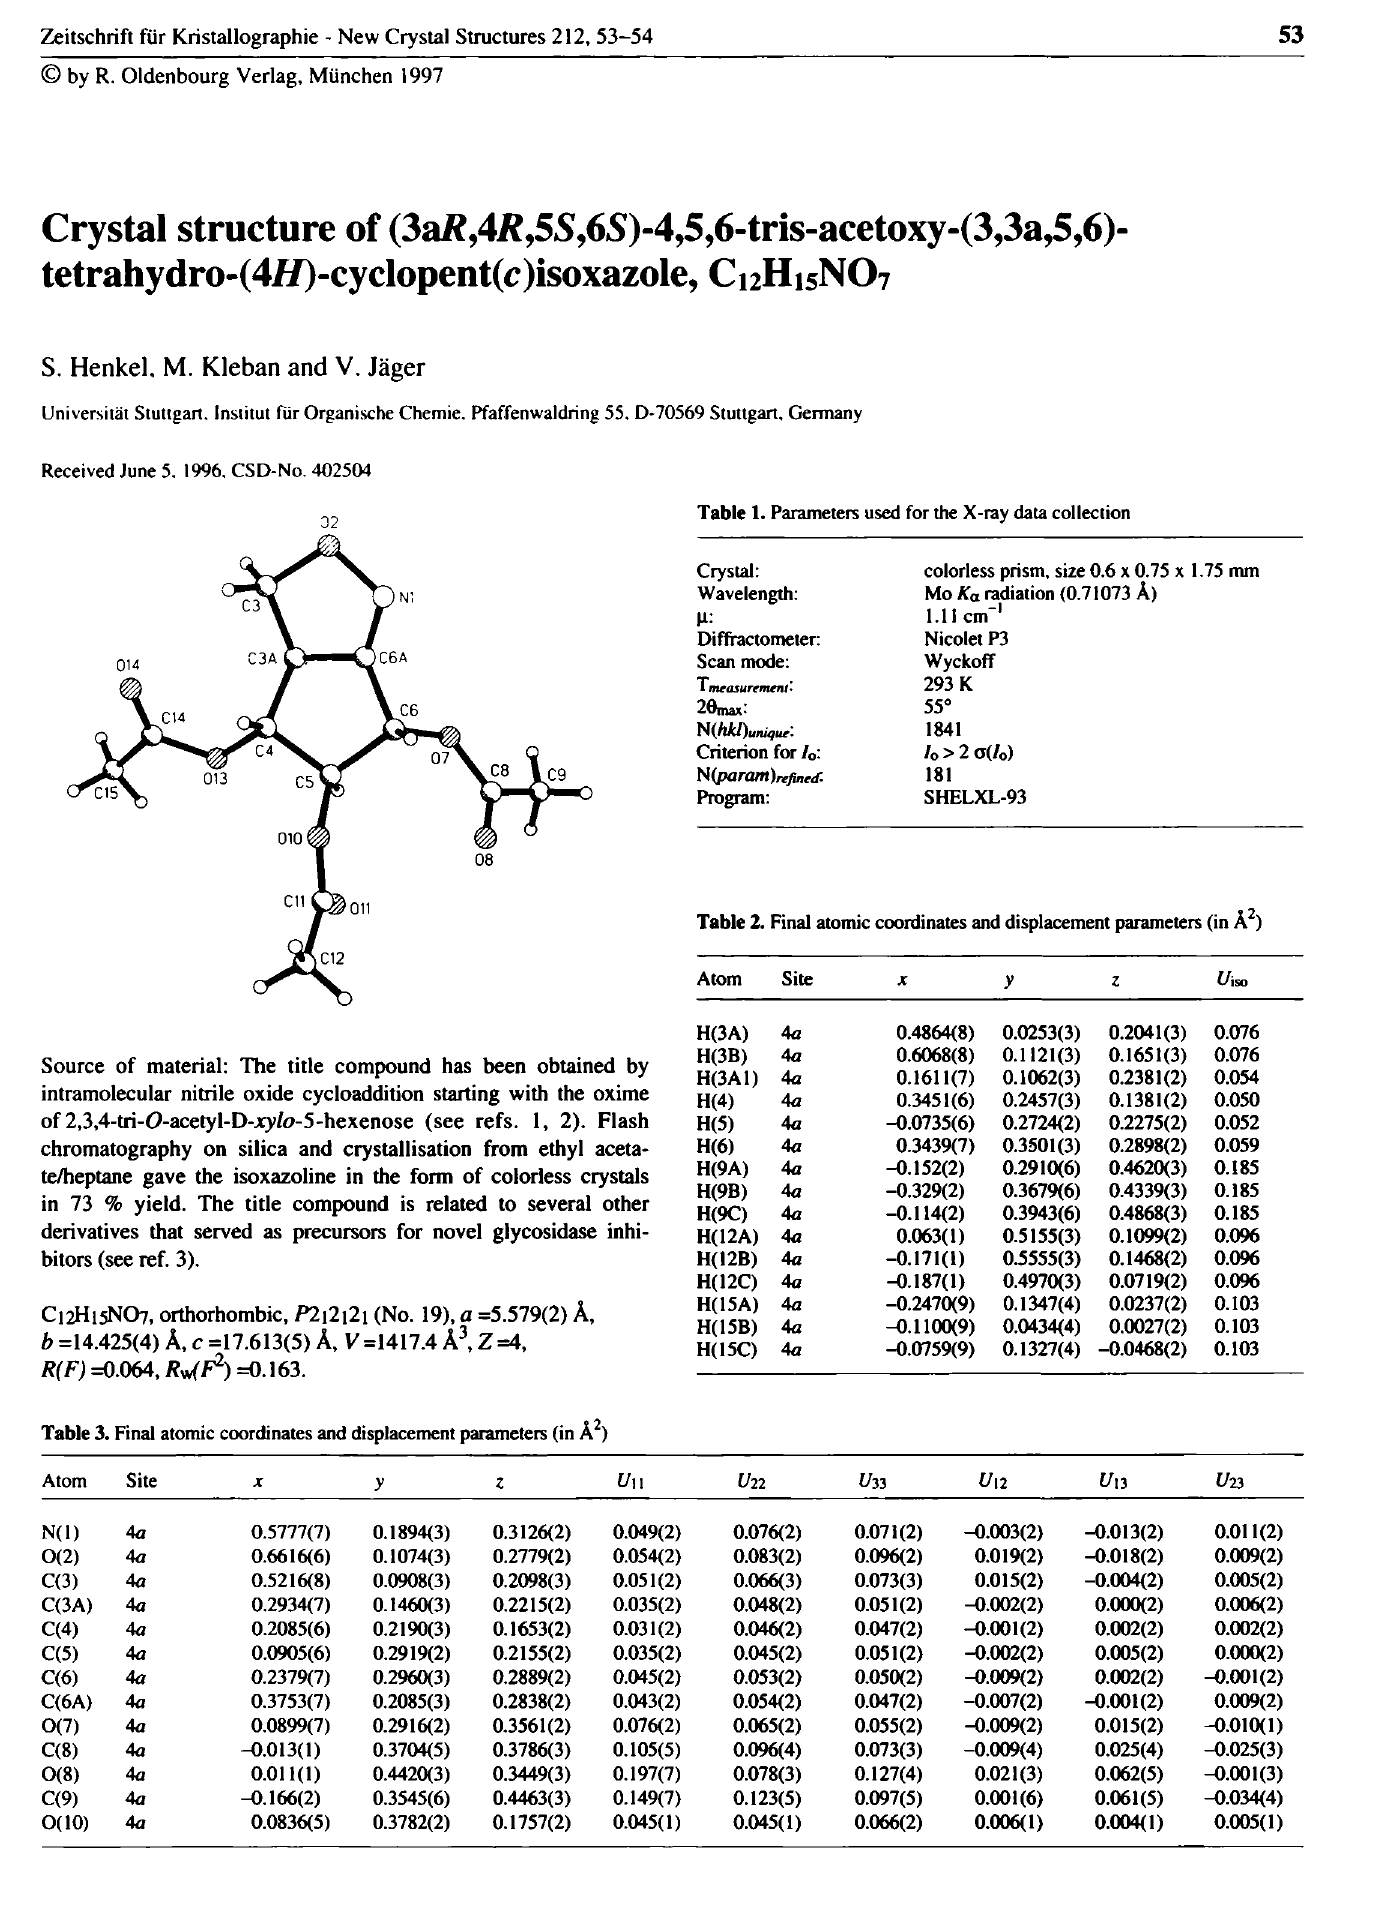
Table 1. Parameters used for the X-ray data collection